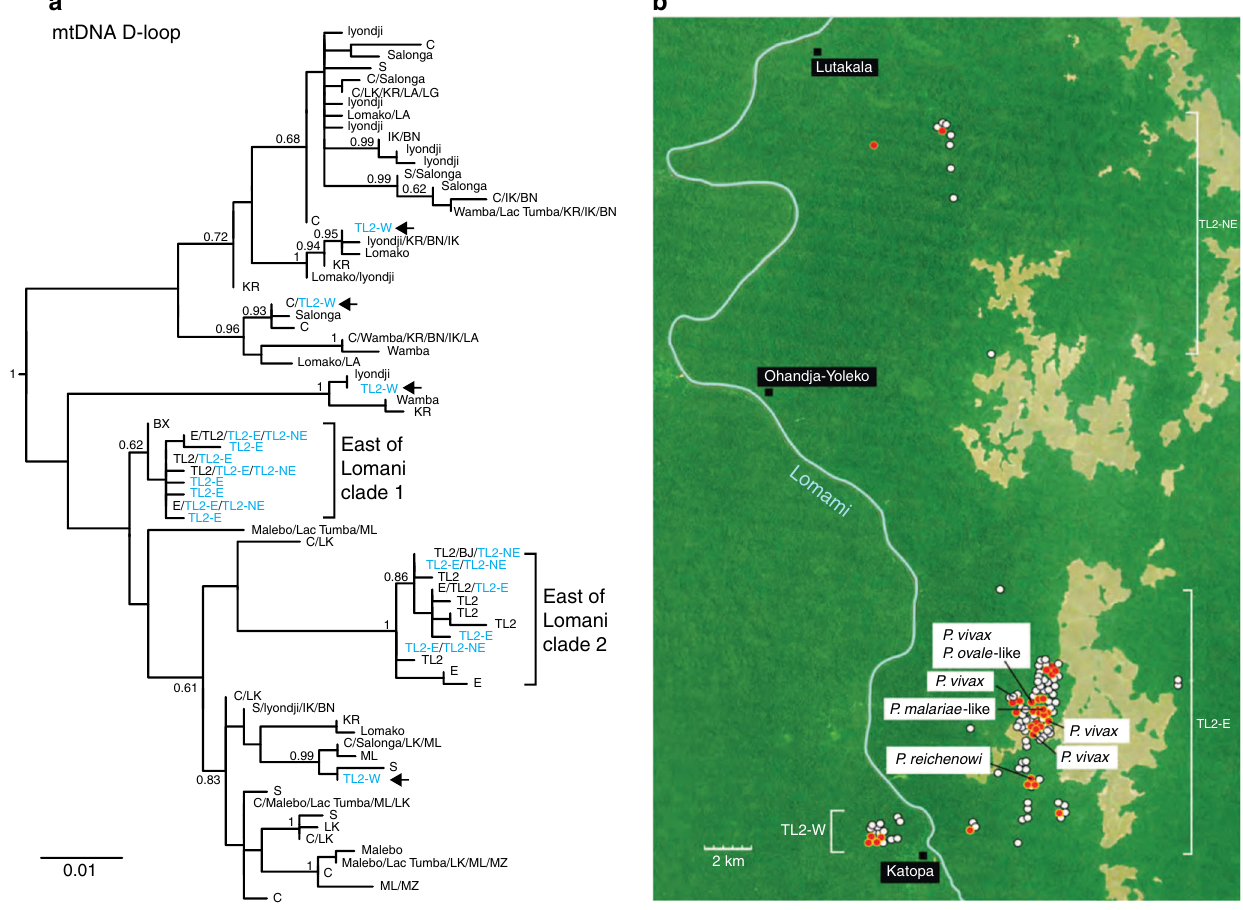
Fig. 5 The Lomami River is not a barrier to Laverania parasite transmission. a Maximum likelihood phylogenetic tree of bonobo mitochondrial (D-loop) sequences. Haplotypes are labelled by fi eld site (see Fig. 1 and refs. 7,22,23,77, for their geographic location and code designation), with those identi fi ed at multiple fi eld sites indicated (e.g., C/Wamba/KR/BN/IK/LA). Newly derived haplotypes from the TL2 site are shown in blue (previously reported mtDNA sequences are shown in black) 22,23,77 . Brackets highlight two clades that are exclusively comprised of mtDNA sequences from bonobos sampled east of the Lomami River. TL2 haplotypes that do not fall within these clades (denoted by arrows) were all sampled west of the Lomami River (TL2-W). The tree was constructed using PhyML 58 with HKY+G as the evolutionary model. Bayesian posterior probability values ≥ 0.6 are shown (the scale bar represents 0.01 substitutions per site). b Locations of individual bonobo faecal samples collected at the TL2 site. Sampling locations west (TL2-W) and east (TL2-E and TL2-NE) of the Lomami River were plotted using GPS coordinates, with red and white dots indicating Laverania parasite positive and negative specimens, respectively. Samples that contained P. reichenowi , P. malariae -like , P. vivax -like and P. ovale -like parasites are also indicated. Forested areas are shown in green, while savannas are depicted in brown. The Lomami River is shown in blue. Local villages are denoted by black squares. The scale